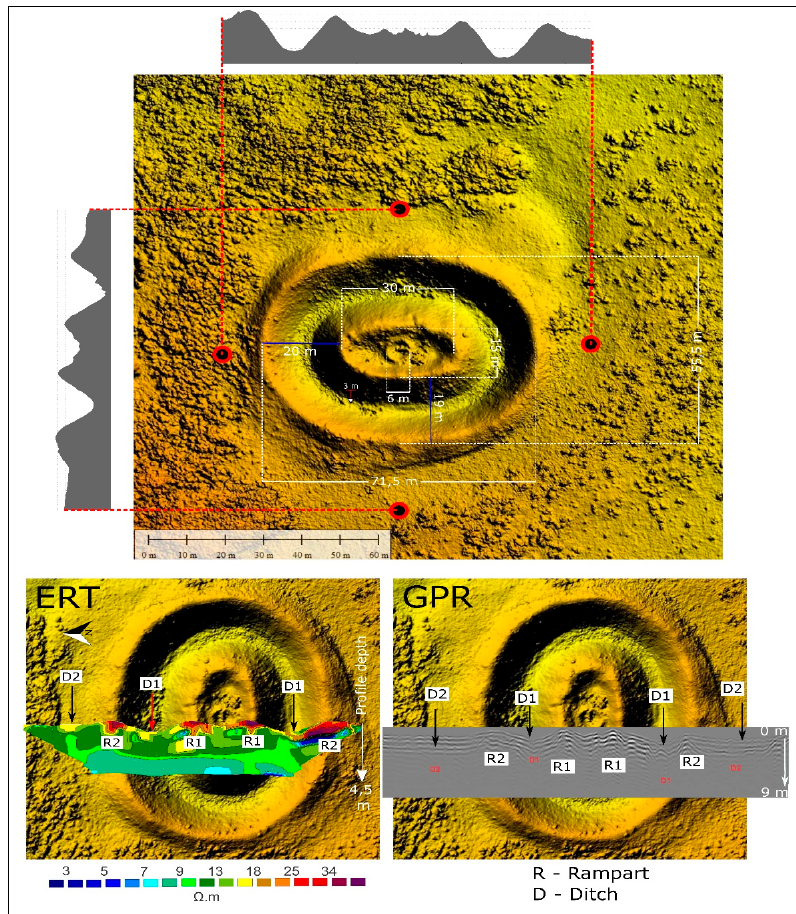
Figure 14. The digital surface model showing today’s preservation of the central fortified structure of the medieval village (top). The ERT (bottom left) and GPR (ground-penetrating radar, bottom right) profiles measured over the rampart and ditches highlight a few aspects regarding their morphology. The ramparts are represented by slightly higher resistivity values (ERT) and by stronger EM reflections (GPR) suggesting the remains of a wall or a palisade. Both ERT and GPR profiles allowed the estimation of the real depth of the ditches and proved the existence of a second outer ditch (D2) enclosing the inner structure.